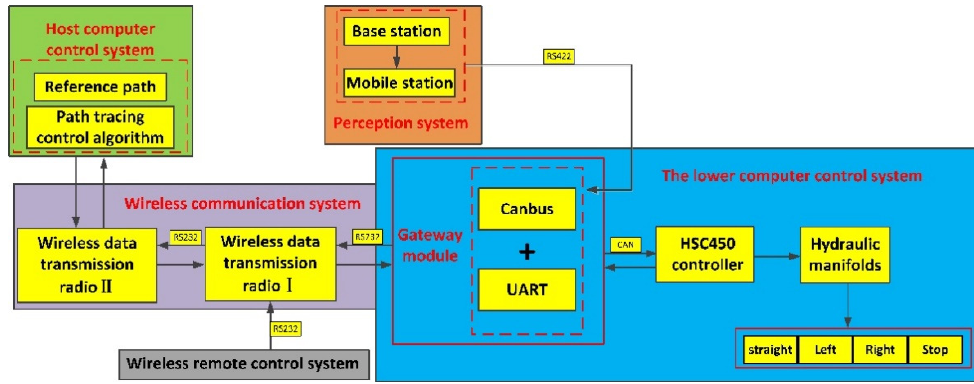
Figure 2. Structure of the navigation control system of the orchard traction spraying robot.